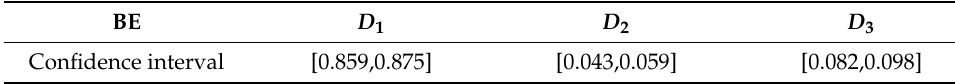
Table 9. The confidence interval of D 1 , D 2 , and D 3.